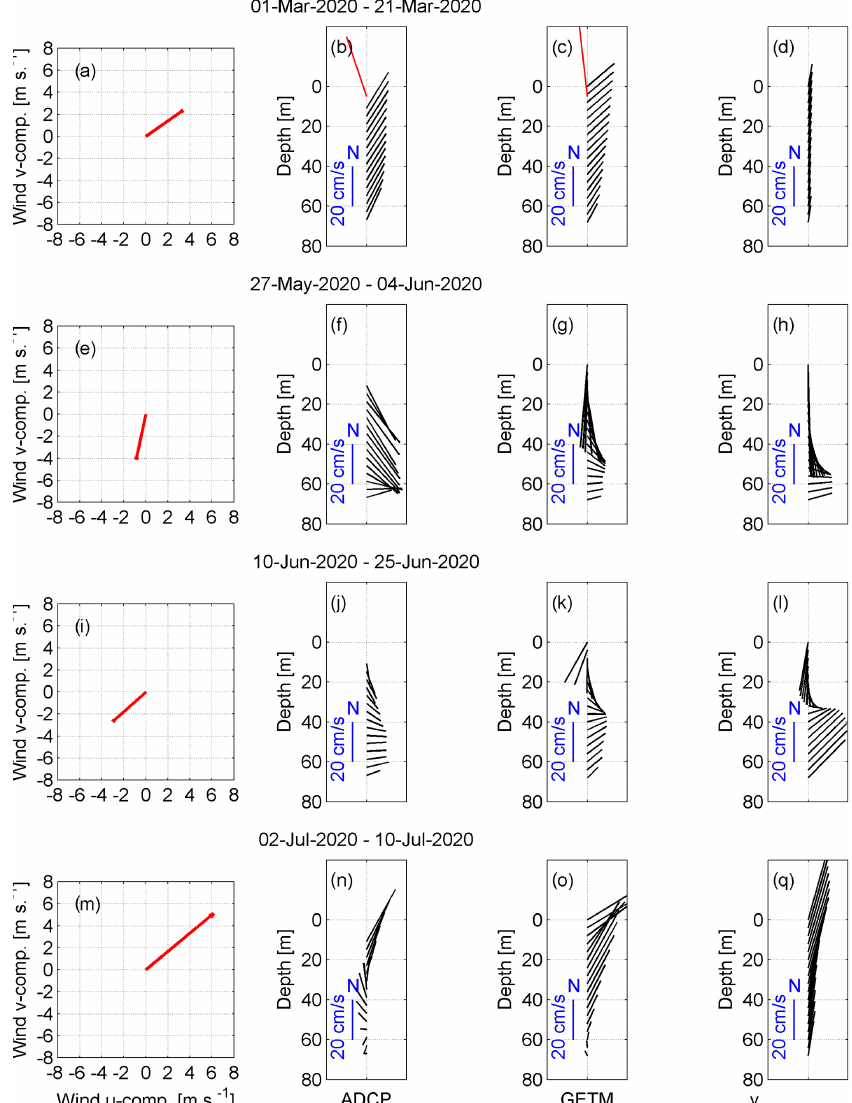
Figure 7. The mean resultant wind vectors (a, e, i, m) , mean profiles of current velocity vectors calculated from ADCP data ( black arrows, b, f, j, n) , and mean simulated current velocity vectors at the ADCP location (c, g, k, o) are shown for selected periods (Fig. 4). The mean current velocity vector at 5m depth based on Valeport data (b , red arrow ) and mean simulated current velocity vector at the Valeport location (c , red arrow ) for the first time period are shown. In the right panels, mean adjusted geostrophic velocity vectors V GEO-ADJ-GETM (d, h, i, q) are